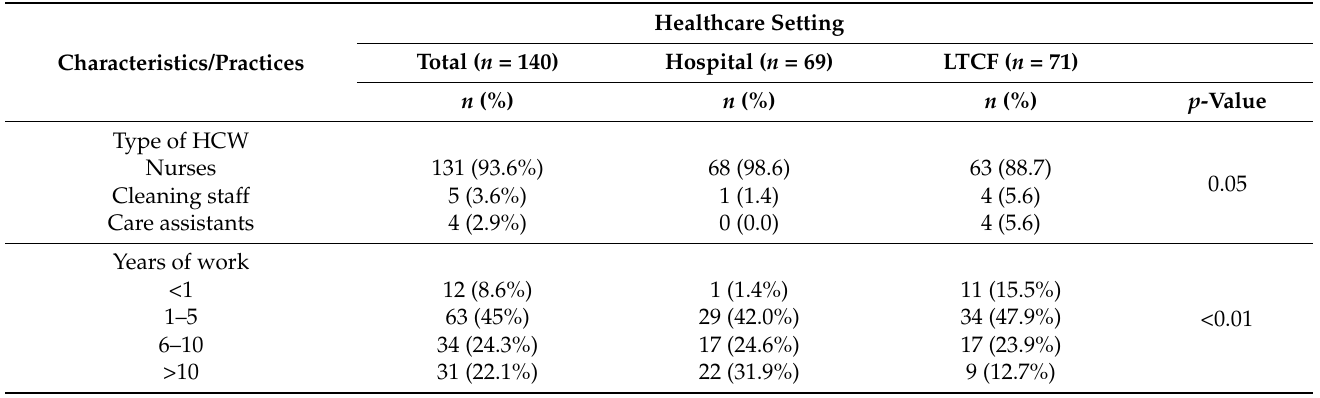
Table 1. Participants’ characteristics and